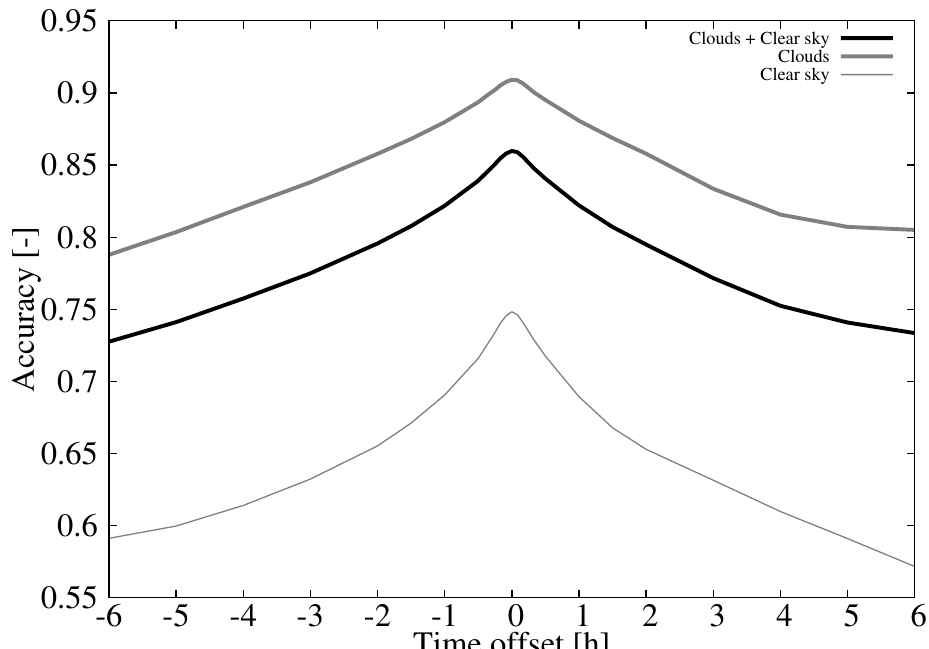
Figure 3. Accuracy of the (1) clouds and clear sky detection (black line), (2) cloud detection (gray thick line), and (3) clear sky detection (gray thin line) as a function of the time